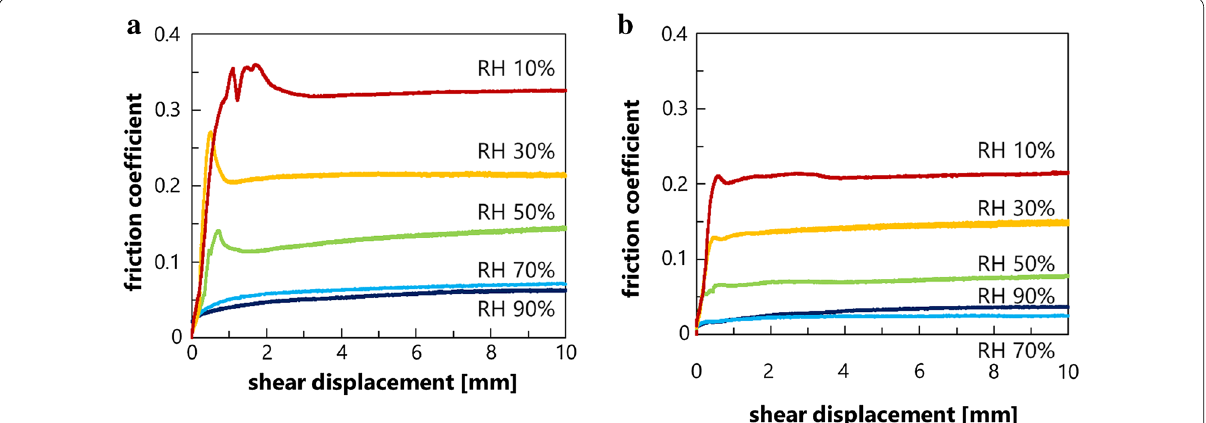
Fig. 5 Experimental results showing variations in friction coefficient with shear displacement for a Na-montmorillonite and b Ca-montmorillonite at different values of relative humidity